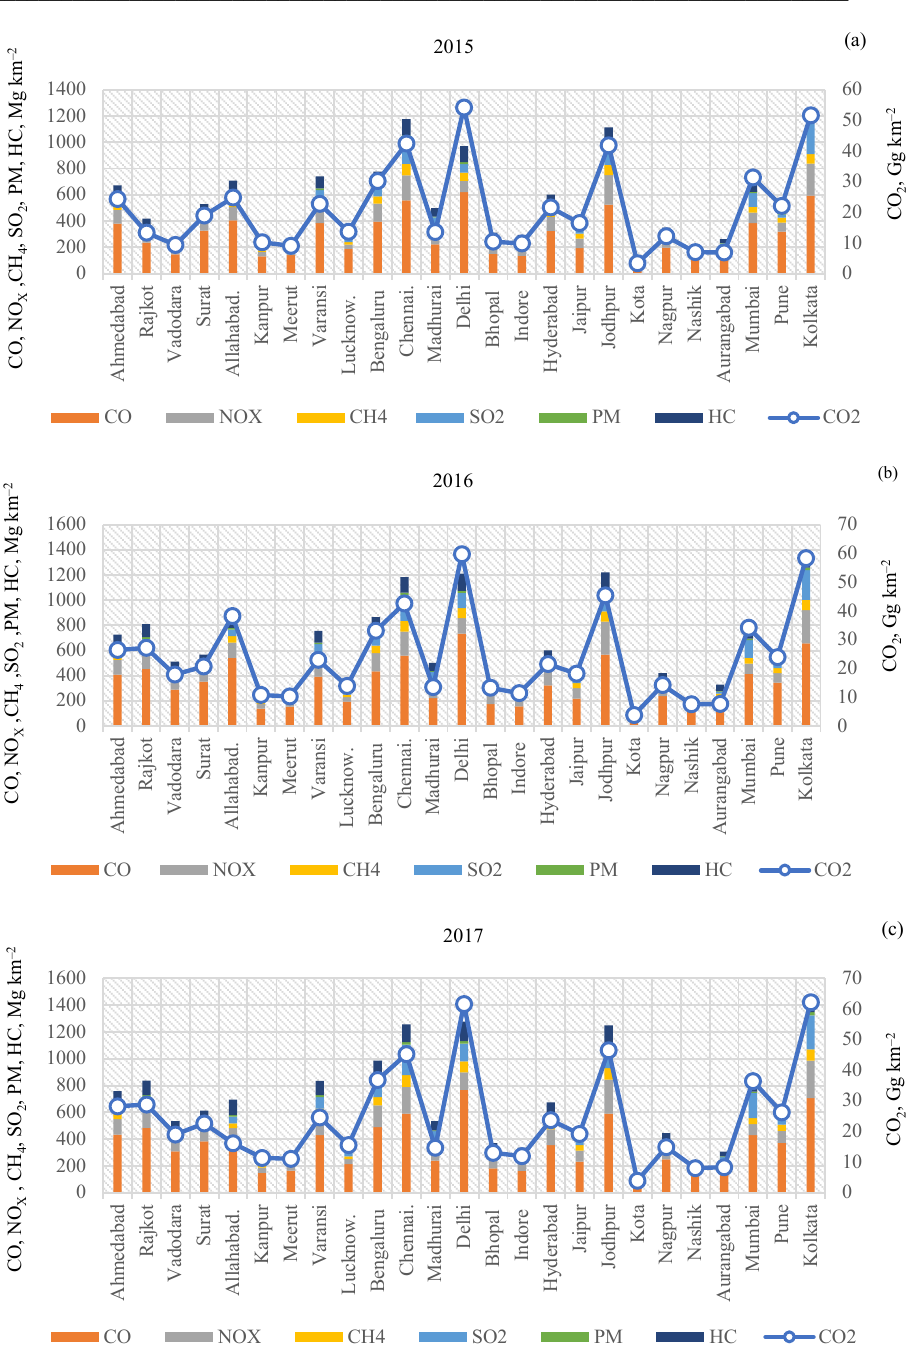
Fig. 4. GHG emission per unit area across 25 cities: A) 2015; B) 2016; C)